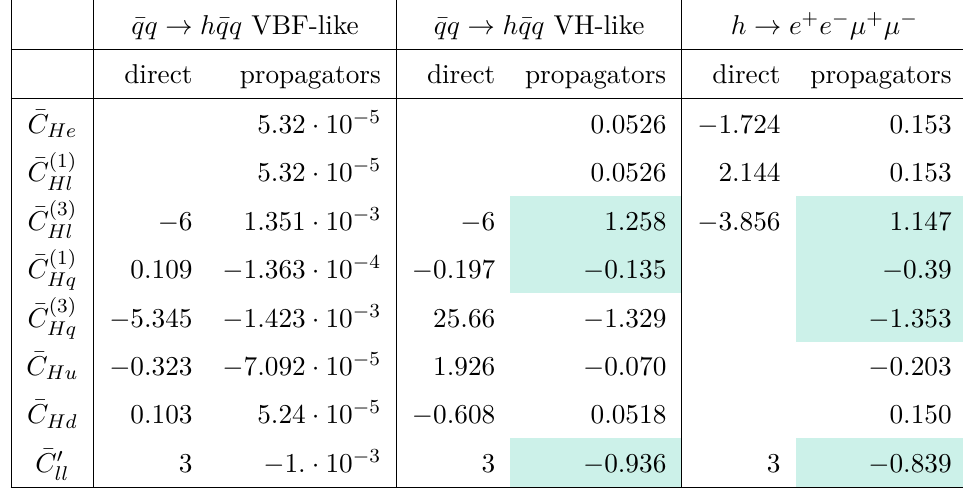
¯ Table 9 . Values of σ a /σ SM for the relevant fermionic Wilson coefficients C α contributing to ¯ qq → h ¯ qq and h → e + e − µ + µ − . For the first two columns σ is the cross section in the VBF-like and VH- like STXS bins defined in the text, while in the third the numbers refer to the partial decay width. The results are given for { m inputs with a U(3) 5 flavor symmetry, and neglecting all W , m Z , G F } fermion masses. The “direct” contributions stem from operator insertions in vertices, including parameter shifts, while the “propagator” ones stem from the corrections to the W, Z decay width in internal propagators. The lines highlighted in color are those for which the latter are most